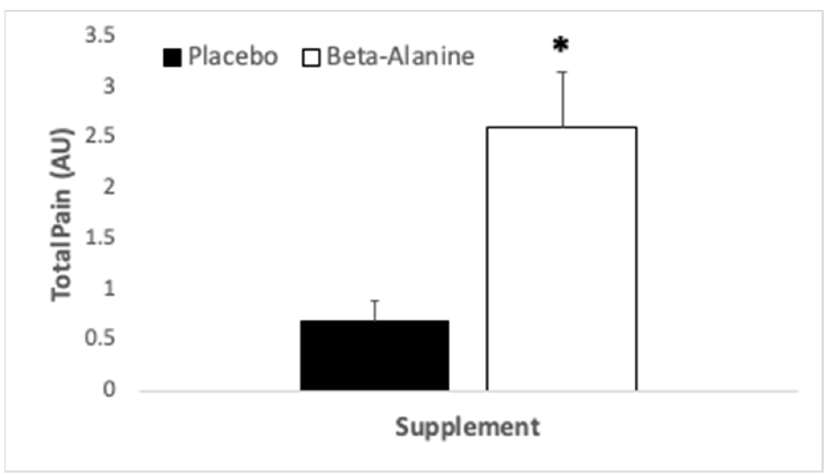
Figure 3. Perception of total pain (arbitrary units), as determined by the McGill Pain Question- naire short form, in participants ( N = 20) who consumed β -alanine prior to immersion in nature and a subsequent hike. * indicates significant difference between supplementation trials.